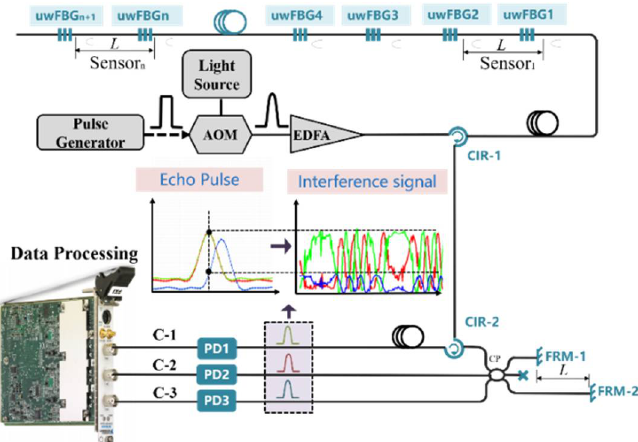
Figure 1. Structure of fiber-optic system with path-match interferometer.